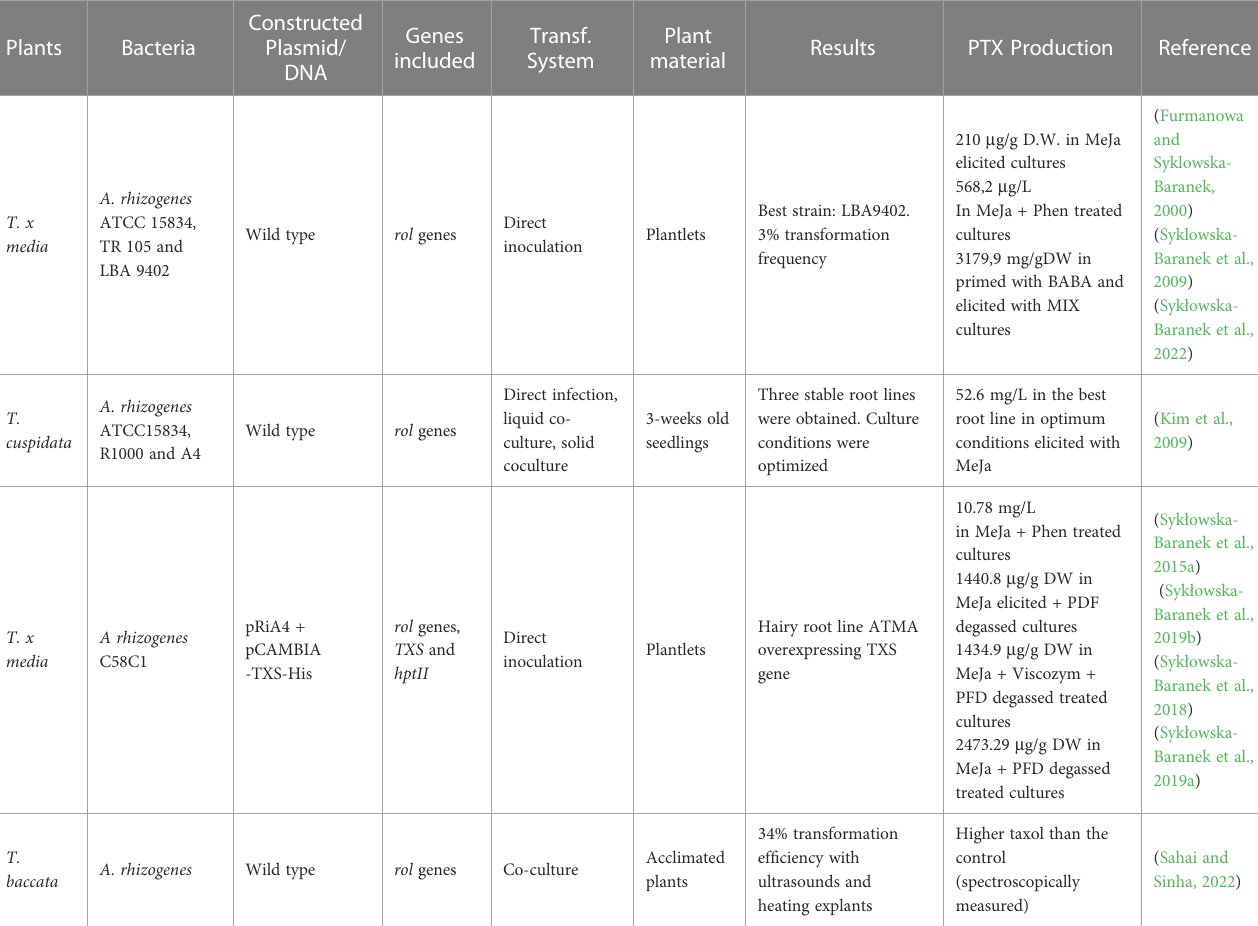
TABLE 2 Taxus hairy root cultures.